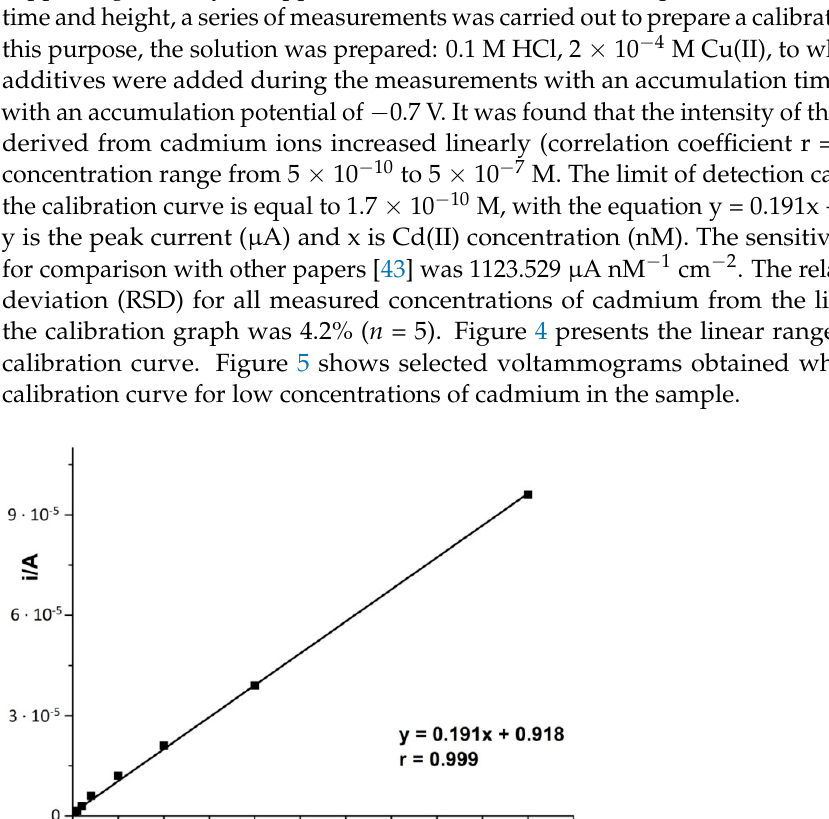
Figure 3. Influence of pulse height ( A ) and pulse time ( B ) on the Cd(II) signal. Composition of solution 5 × 10 − 8 M Cd(II), 2 × 10 − 4 M Cu(II), and 0.1 M HCl. Accumulation potential − 0.7 V, accumulation time 210 s.